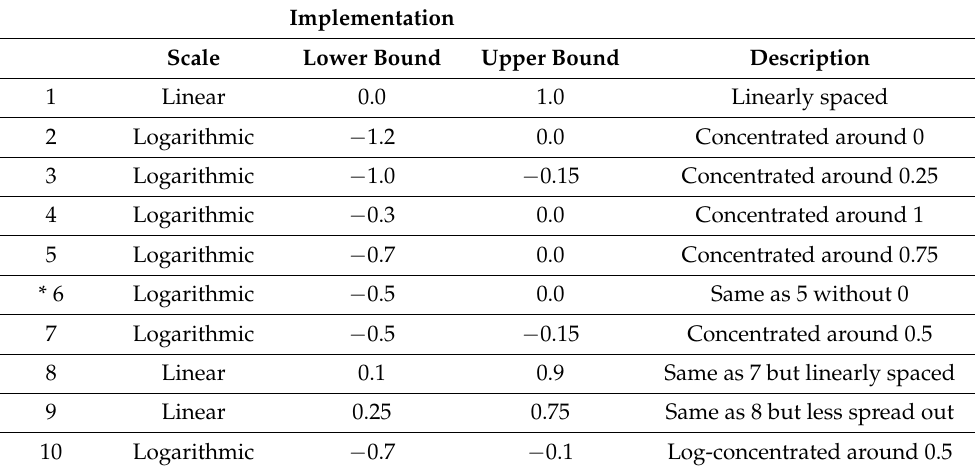
Table 2. Metrics used during theoretical and experimental tests. For a given number of points T , we have the following 10 metrics as depicted in Figure